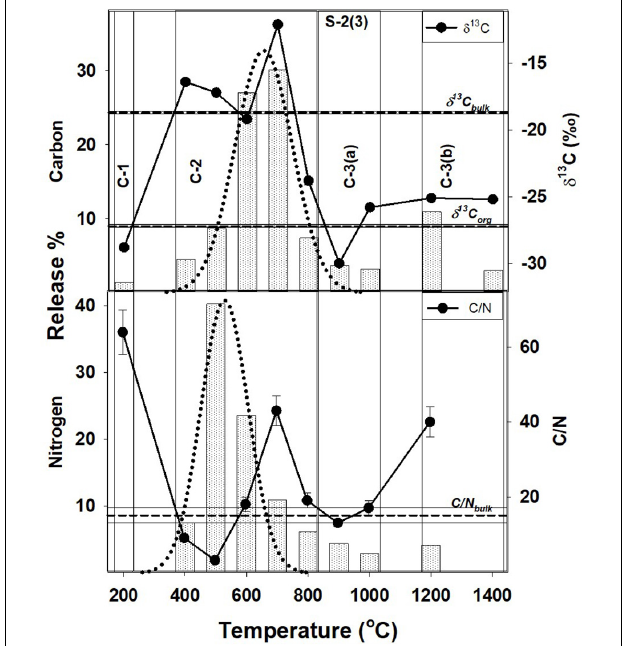
FIGURE 1 | Step combustion temperature vs. carbon and nitrogen release percent for S-2(1). The δ 13 C and C/N for each temperature step are shown along with the bulk C/N and δ 13 C (C/N bulk , δ 13 C bulk ), and, organic δ 13 C ( δ 13 C organic ) ratios. The different OC components, C-1, C-2, C-3(a) and C-3(b), released at different temperature due to differences in their stability